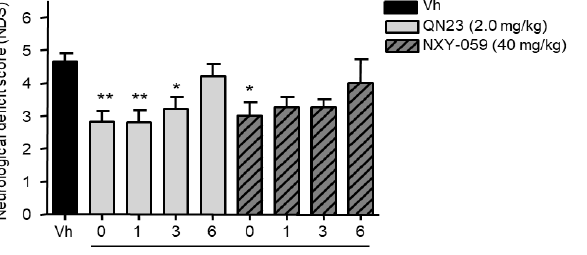
Figure 6. Neurodeficit score outcomes after cerebral ischemia in the therapeutic window study of QN23. The bar graph shows the neurological deficit score (NDS) in ischemic animals after 5 days of reperfusion after ischemia. Animals were treated with QN23 (2.0 mg/kg), NXY-059 (40 mg/kg), or vehicle (Vh) by intravenous injection at the reperfusion onset (0 h), or after 1, 3, or 6 h of post-ischemic reperfusion. For each group, 6–10 independent animals (as described in Figure 4) were averaged; error bars indicate the SE, * p < 0.05 and ** p < 0.01 compared with vehicle by Dunn’s post-test after Kruskal–Wallis test.